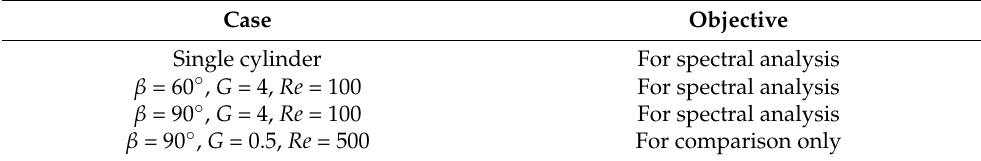
Table 1. Cases in the study.